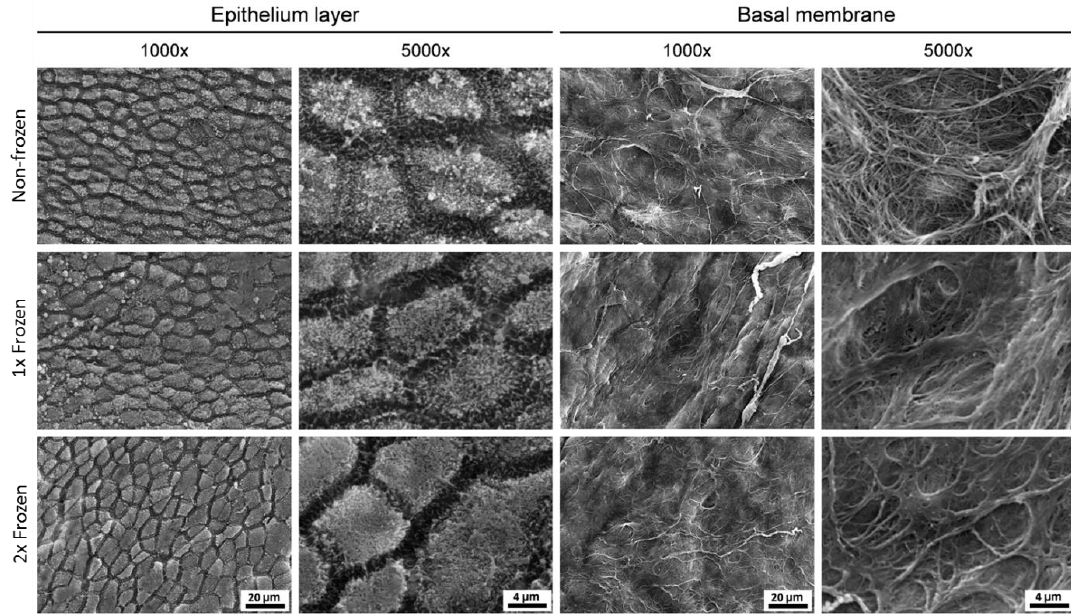
Figure 3. Representative SEM images of the non-frozen, one-time frozen (1×), and two times frozen (2×) hAM. The images at 1000× and 5000× magnification show the epithelium layer and the basal membrane. Scale bars are 20 and 4 µm for 1000× and 5000× magnifications, respectively.